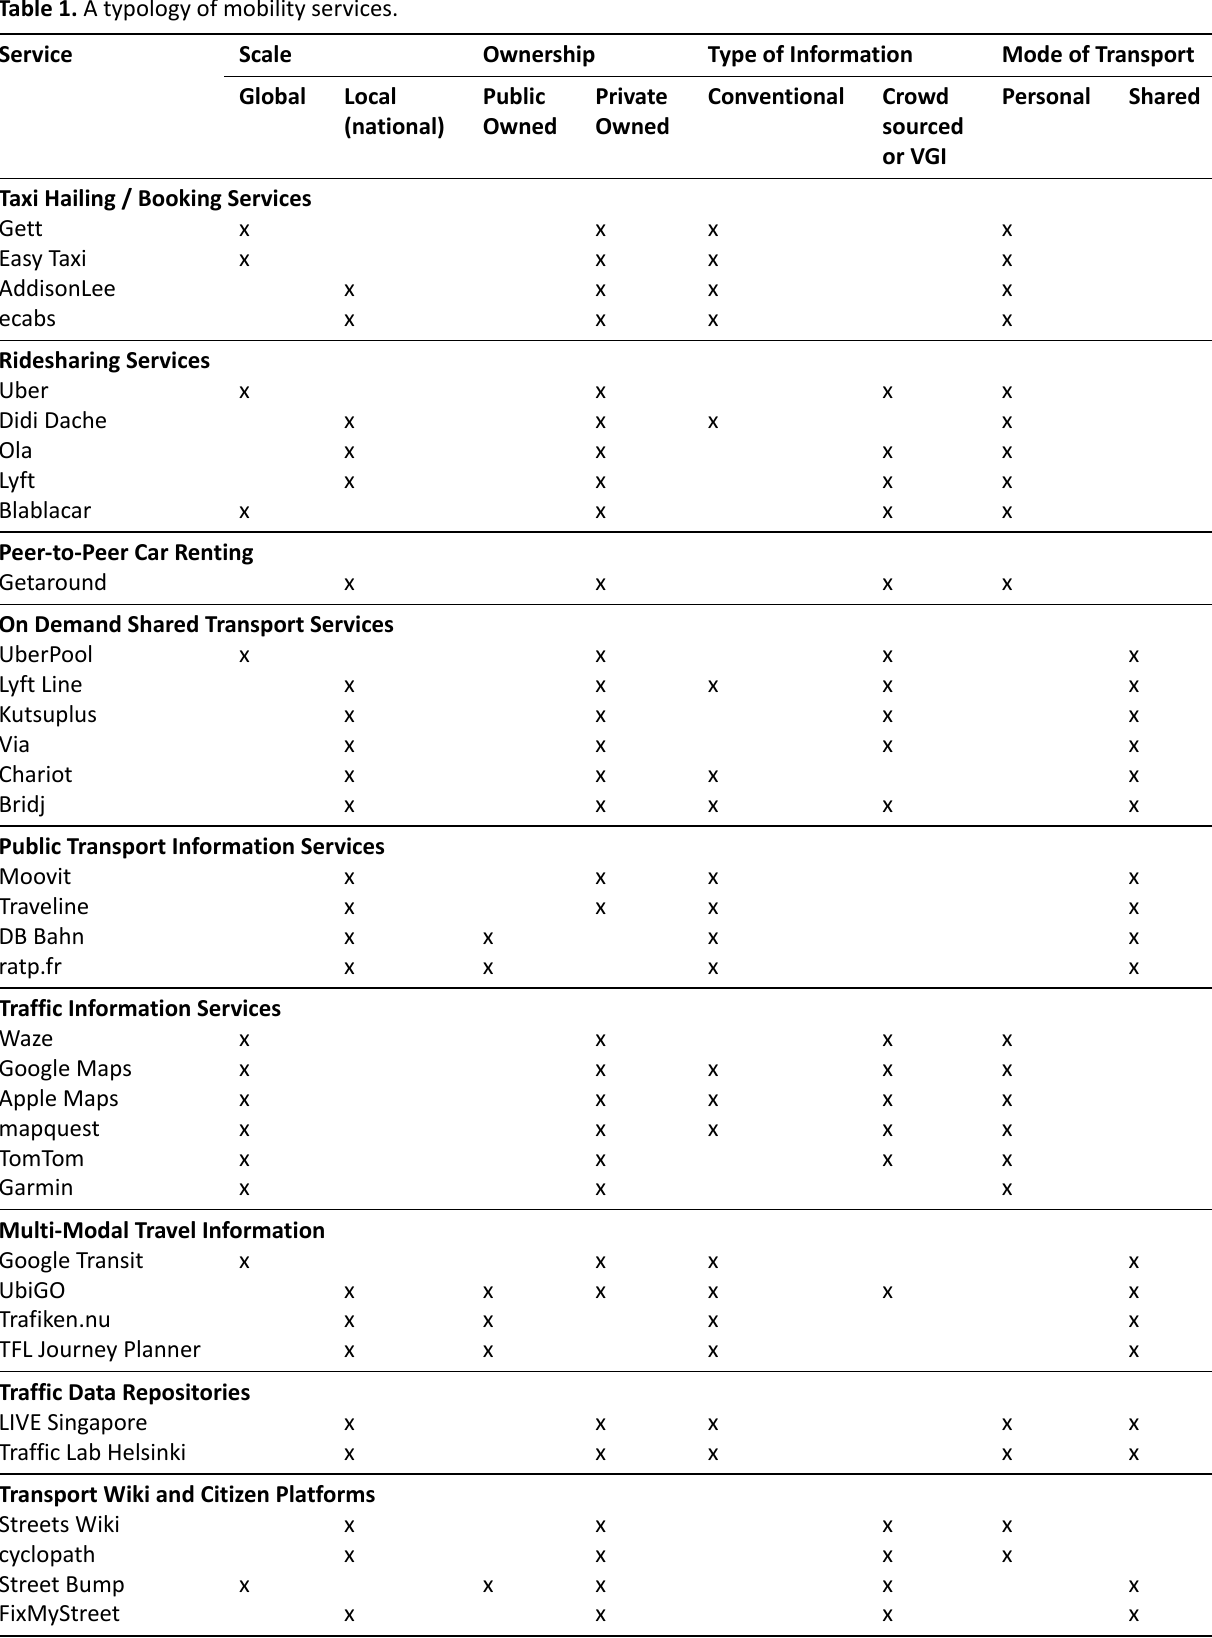
Table 1. A typology of mobility services.